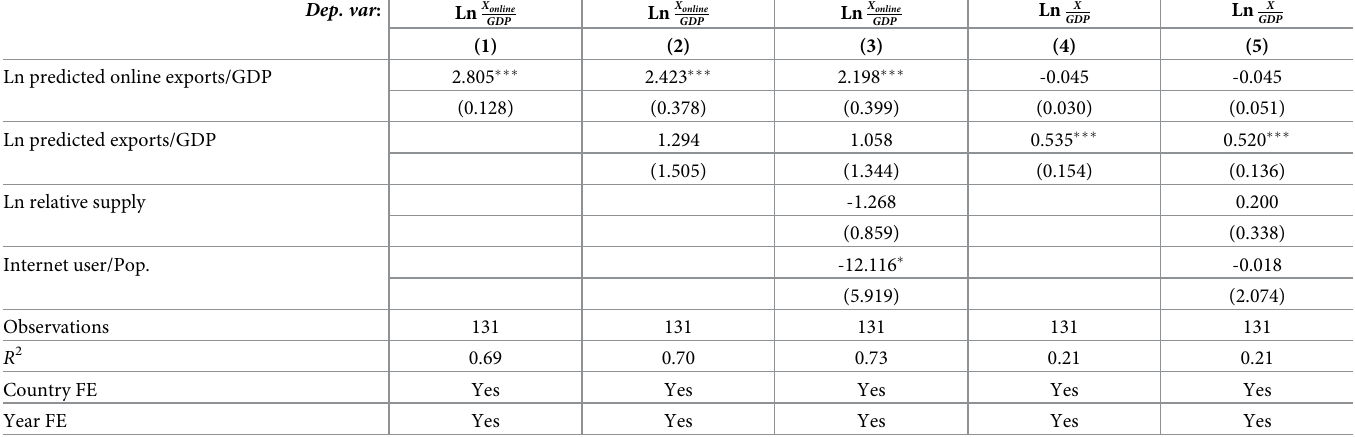
First stage regressions are reported in Table 5 and show strong correlations between online or total exports and their respective instruments, but not across online and total exports. The F statistics are above 10 in all regressions. The R 2 are also quite high for online exports at around 70%, but relatively low for total exports at around 21%. In column (1) we report first stage results for online exports using only the predicted online exports as an instrument. In columns (2) and (4) we report first stage results without controlling for the log of relative supply of skilled and unskilled labor, and the share of internet users in total population as arguably these variables may also be endogenous and introduce a bad control problem. Columns (3) and (5) report results using all instruments. Table 6 provides the instrumental variable estimates of Eq (1). All regressions include coun- try and year fixed effects. In the first column we report results using only predicted share of online exports on GDP as an instrument for share of online exports on GDP, without control- ling for total exports, nor other covariates. In columns (2) and (3) we report results with share of online and total exports on GDP instrumented by predicted share of online and total exports on GDP. Yet, in column (2) we do not control for the relative supply of skilled and unskilled workers, as well as the share of internet users in the population. Arguably these Table 5. First stage